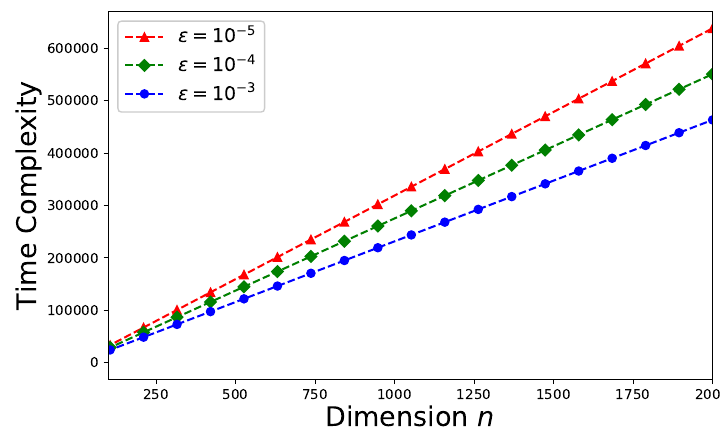
Figure 7. Time-complexity versus n for an arbitrary consistent system ( k = 100, m = 1.25 n ).